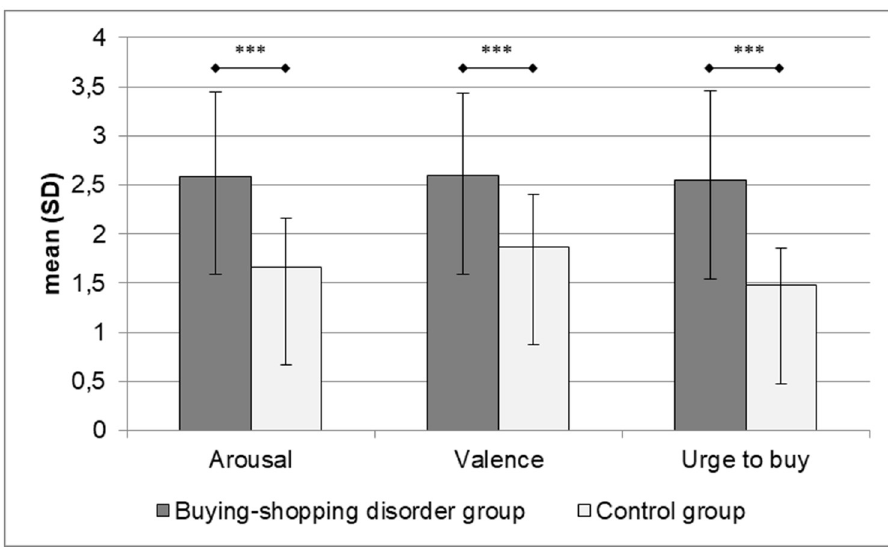
Fig 2. Subjective ratings of buying-shopping pictures. ��� p <